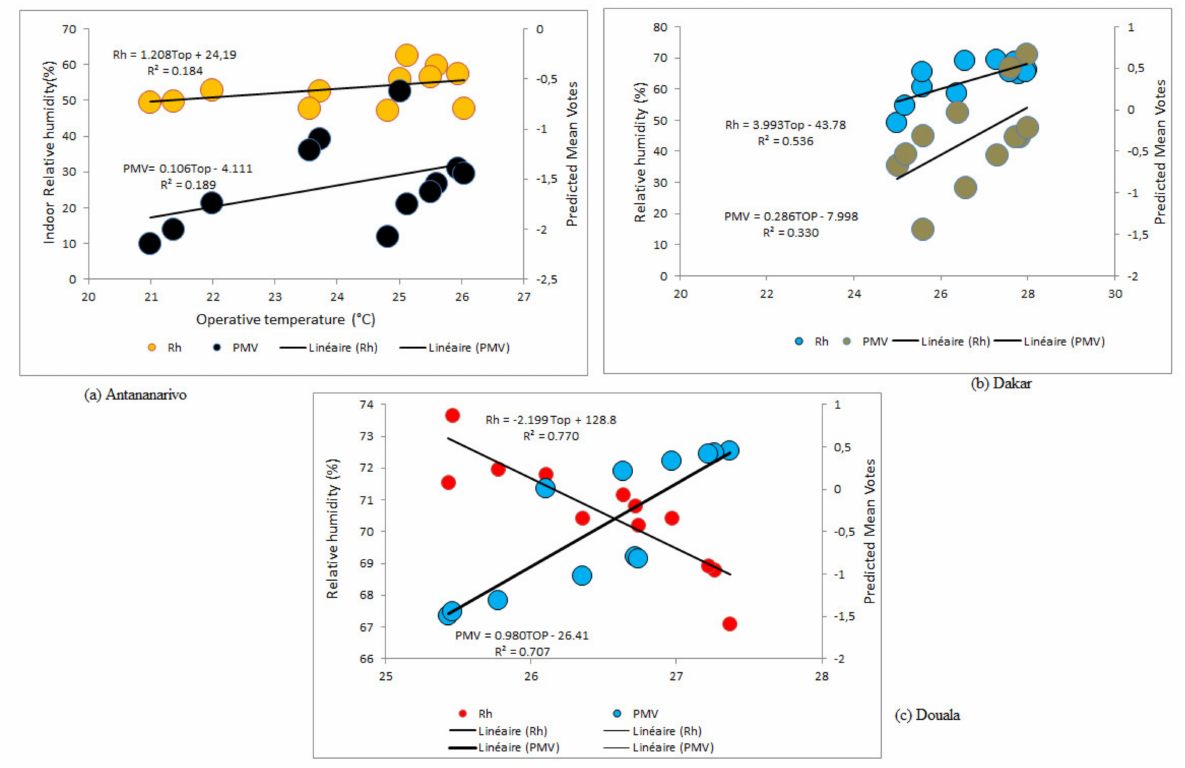
Figure 5. Variation of relative humidity and Predicted Mean Votes function of operative temperature in: ( a ) Douala; ( b ) Antananarivo; ( c )